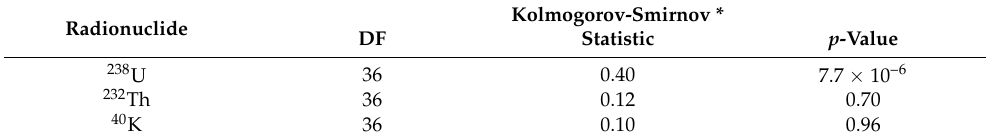
Table 4. Results of normality